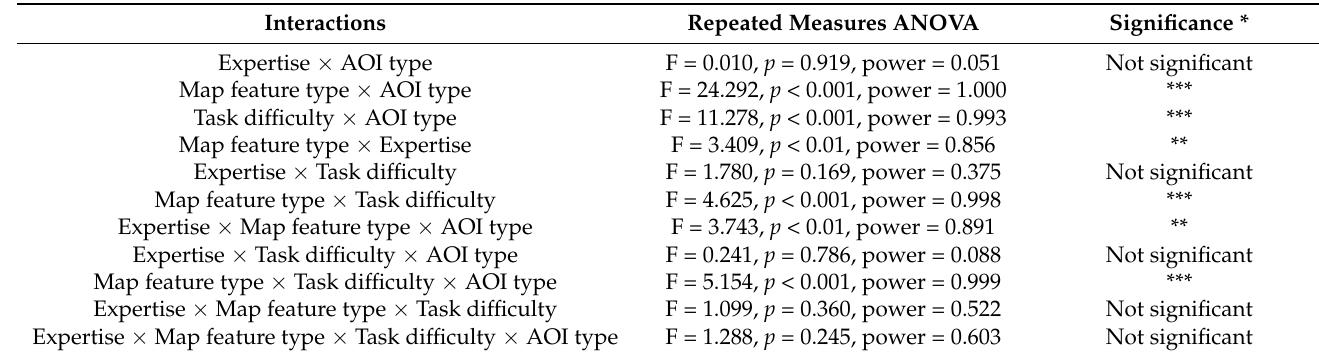
Table 3. Interaction effects of independent variables and within- vs. outside AOI